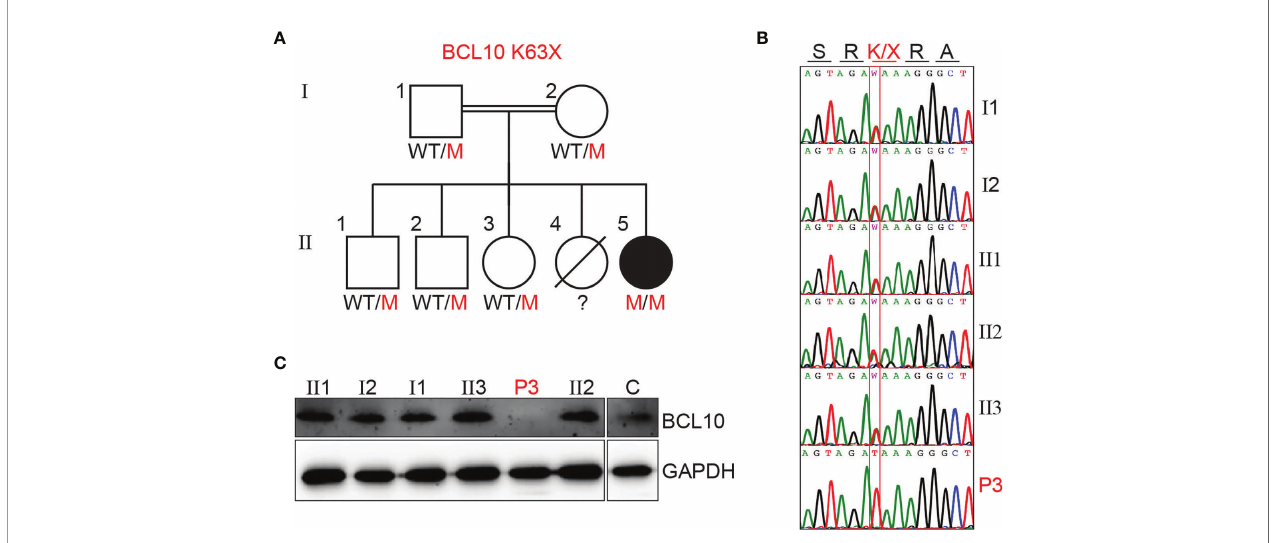
FIGURE 1 | BCL10 de fi ciency in a patient with CID. (A) Familial segregation of the mutation K63X in BCL10. (B) Sanger sequencing results of P3 and her family members in the region spanning the BCL10 mutation. The amino acid consequence is indicated above the graphs. (C) Immunoblot analysis of BCL10 protein in PBMC of the patient (P3), parents (I1, I2), siblings (II1, II2, II3), and healthy control (C). GAPDH was used as a loading control. The panels illustrate the results from a single experiment, representative of